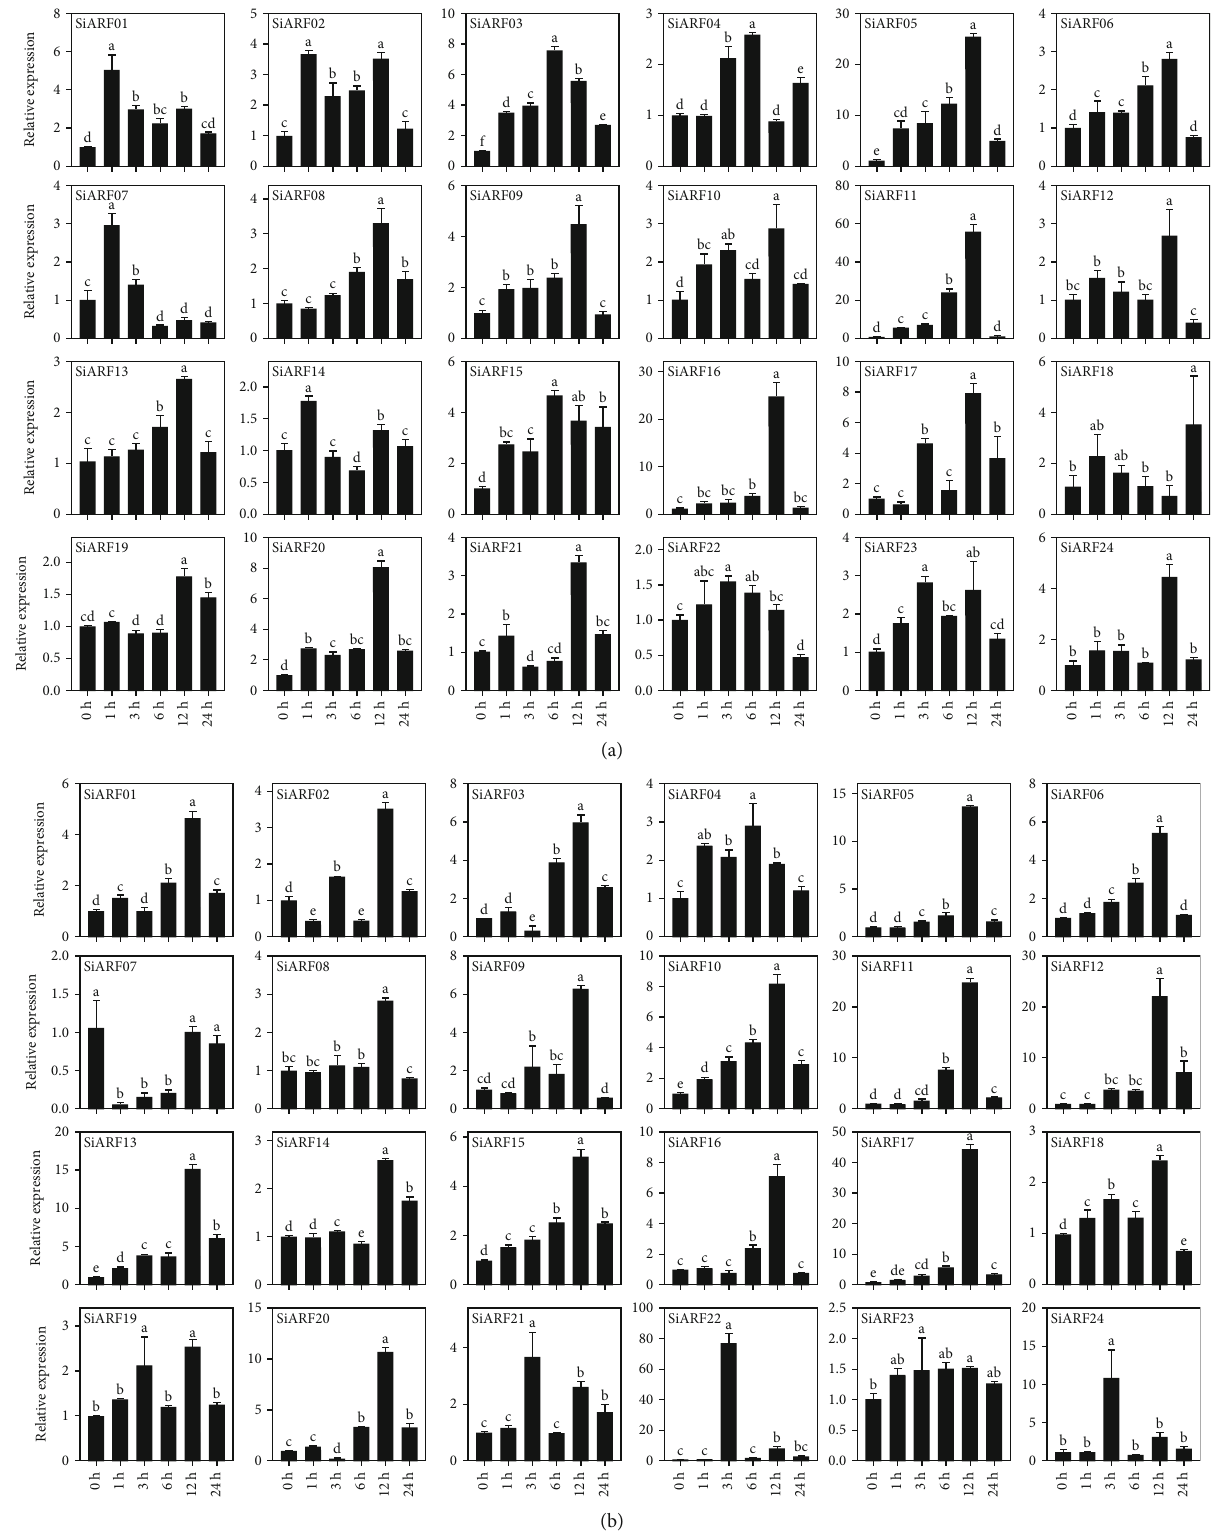
Figure 8: The relative expression of 24 SiARFs analyzed using real-time quantitative PCR under (a) PEG stress treatment and (b) salinity stress treatment after 0 h, 1h, 3h, 6 h, 12h, and 24h. All the experimental results were based on three biologic replicates. Error bars imply ± SD for three biological replicates. Di ff erent letters indicate signi fi cant di ff erences ( p < 0 : 05